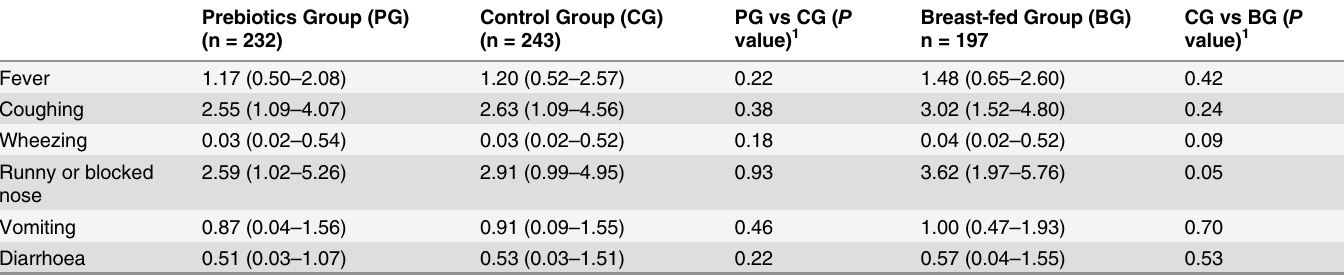
Table 4. Adjusted frequency of febrile episodes per year from third to fifth birthday, median and 25 – 75 percentiles. Prebiotics Group (PG) (n =